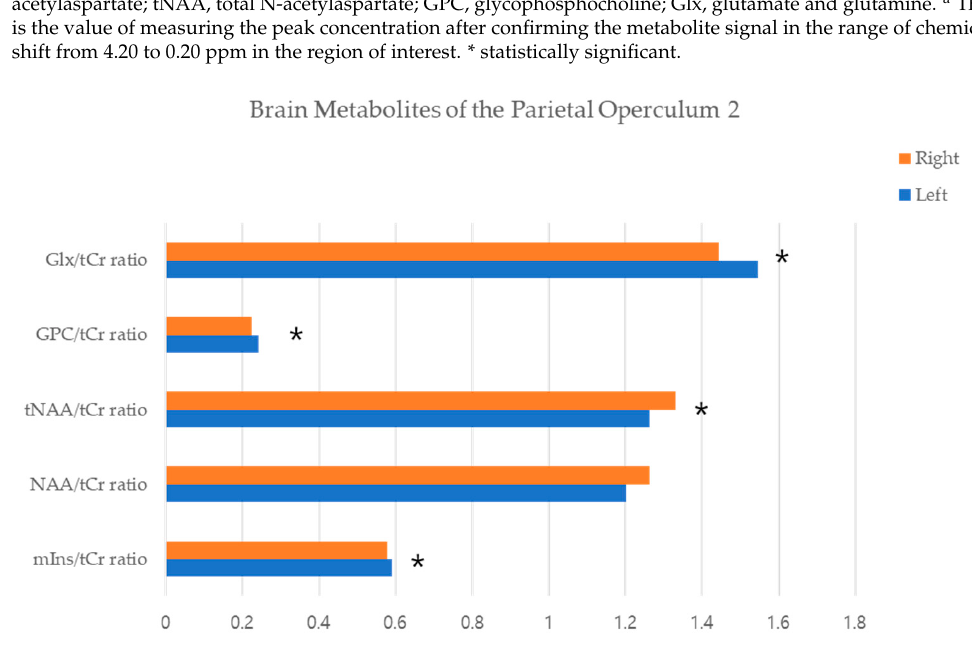
Figure 5. Correlation between metabolite levels and age in the parietal operculum 2. Brain metabolites of the Parietal Operculum 2. Abbreviations: Glx, glutamate and glutamine; tCr, total creatine; GPC, glycophosphocholine; tNAA, total N-acetylaspartate; NAA, N-acetylaspartate; mIns, myo-inositol. * statistically significant Table 3. Correlation Between Metabolite Levels and Age in the Parietal Operculum 2 a.